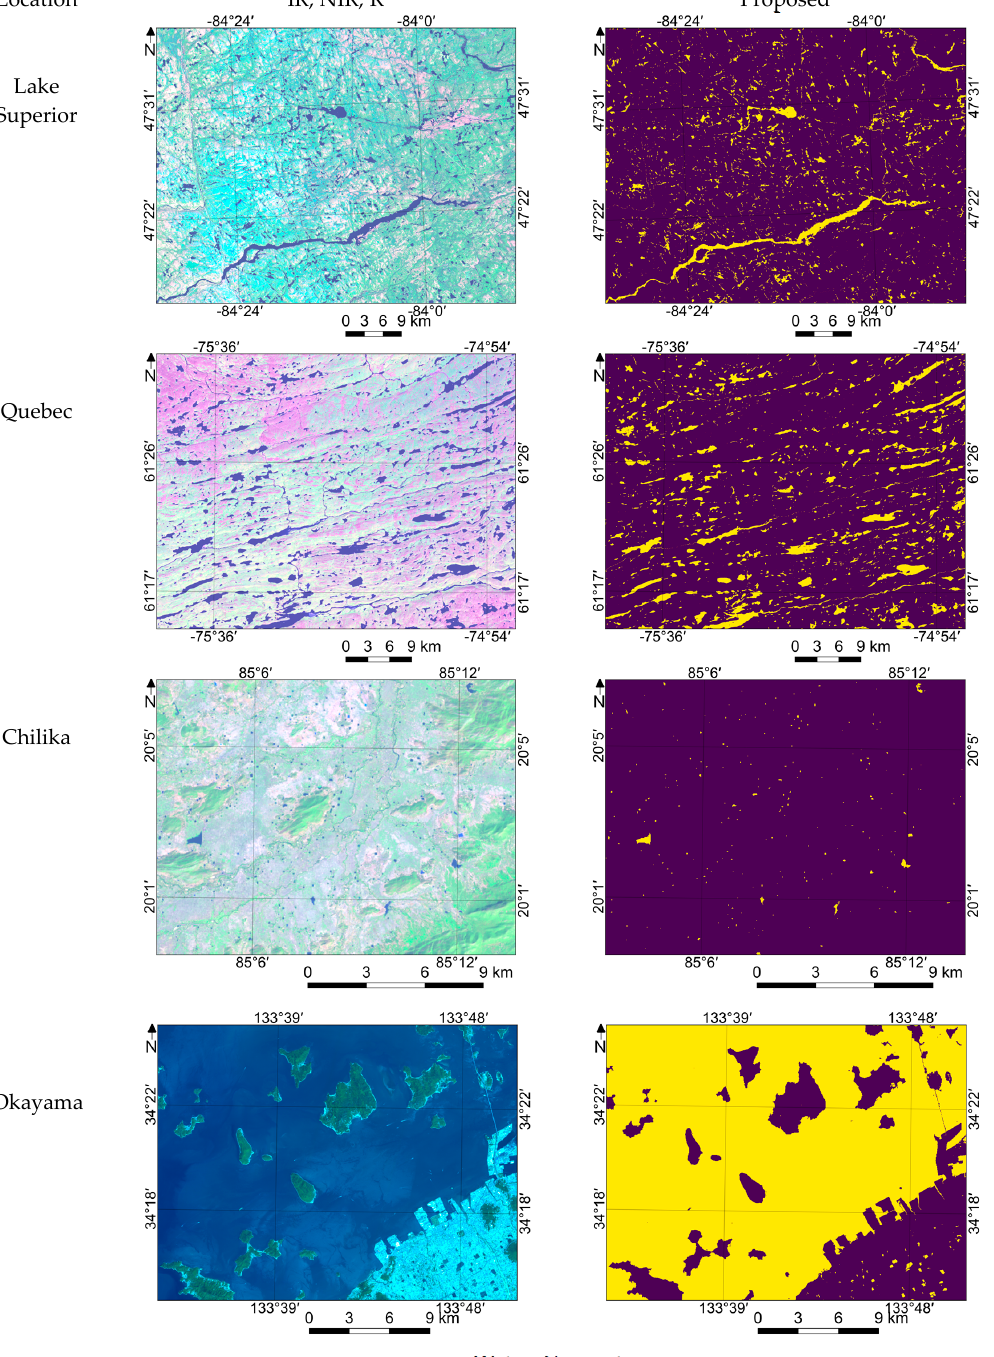
Figure 7. Demonstration of results in detecting smaller water and non-water features.